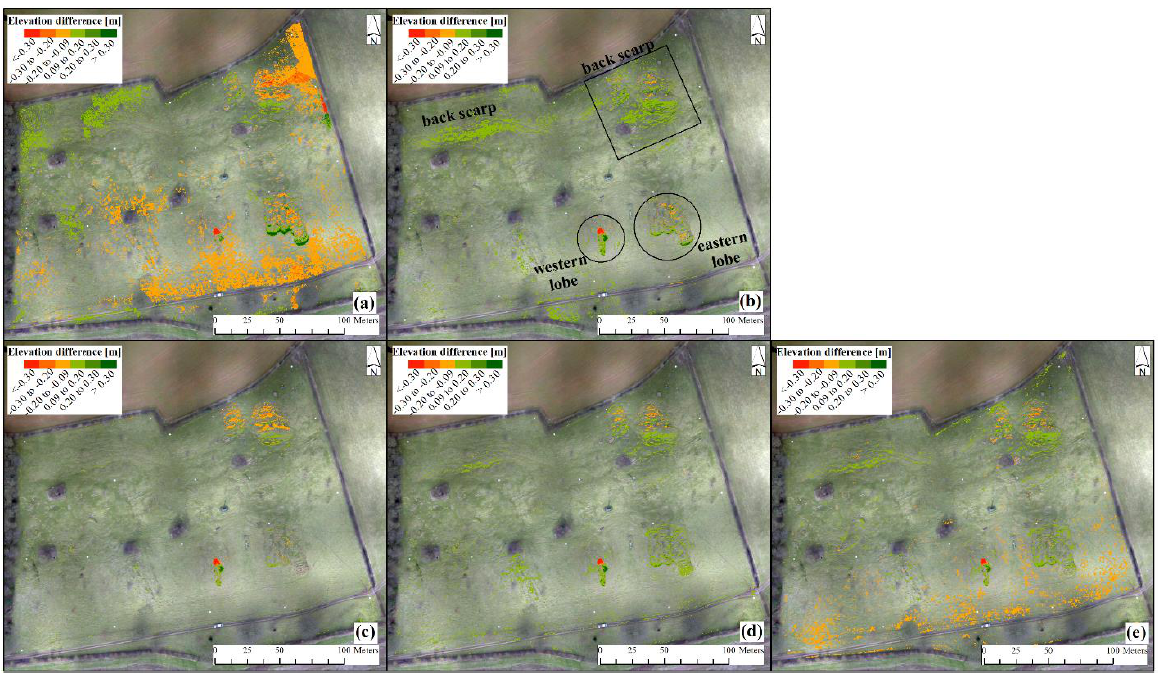
Figure 7. Elevation differences between epoch pairs; (a) February 2016-May 2014, (b) February 2016-December 2014, (c) February 2016-March 2015, (d) February 2016-June 2015, (e) February 2016-September 2015. The orthomosaic of the February 2016 epoch, constructed in PhotoScan, is displayed as the background. Grass growth in May 2014 and September 2015 are observed as